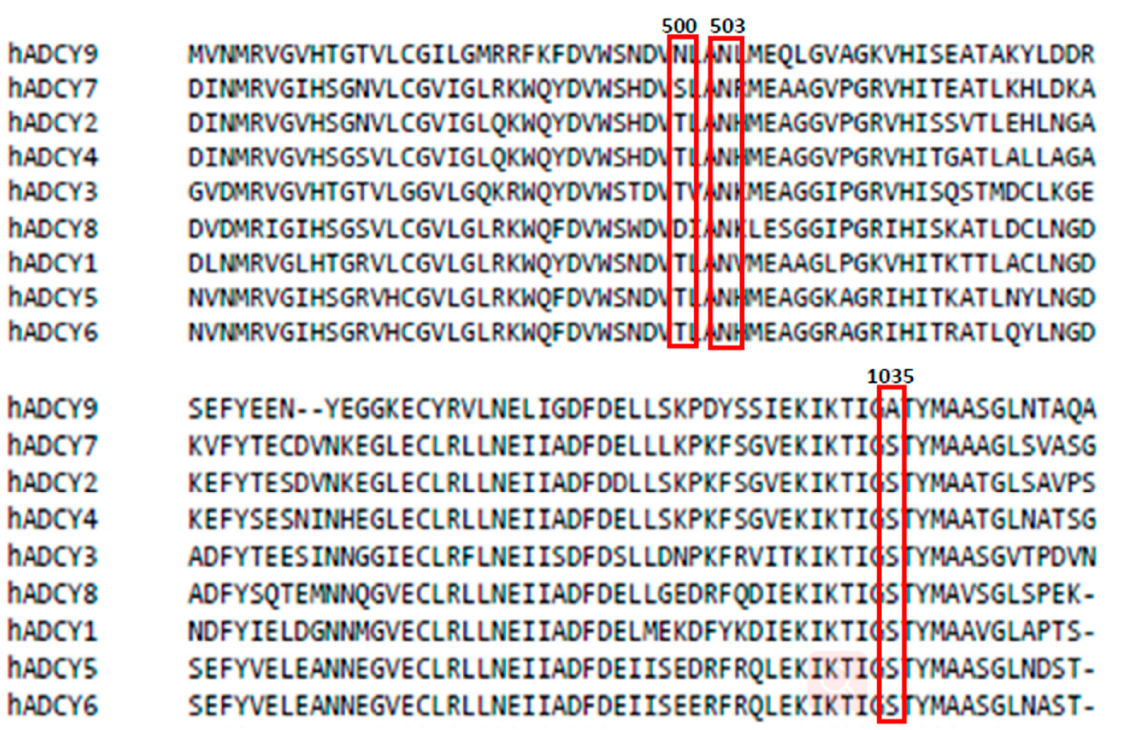
Figure 3. Multiple sequence alignment of all 9 human AC isoforms protein sequences. The amino acid sequences were retrieved from the UniProt database, and sequence alignment was performed using Clustal omega. The amino acid residues selected for mutational studies are highlighted in the red bracket. Amino acids selected for mutation in the AC6 isoform are conserved in all human adenylate cyclase isoforms, except Threonine (T500) in catalytic domain C1.